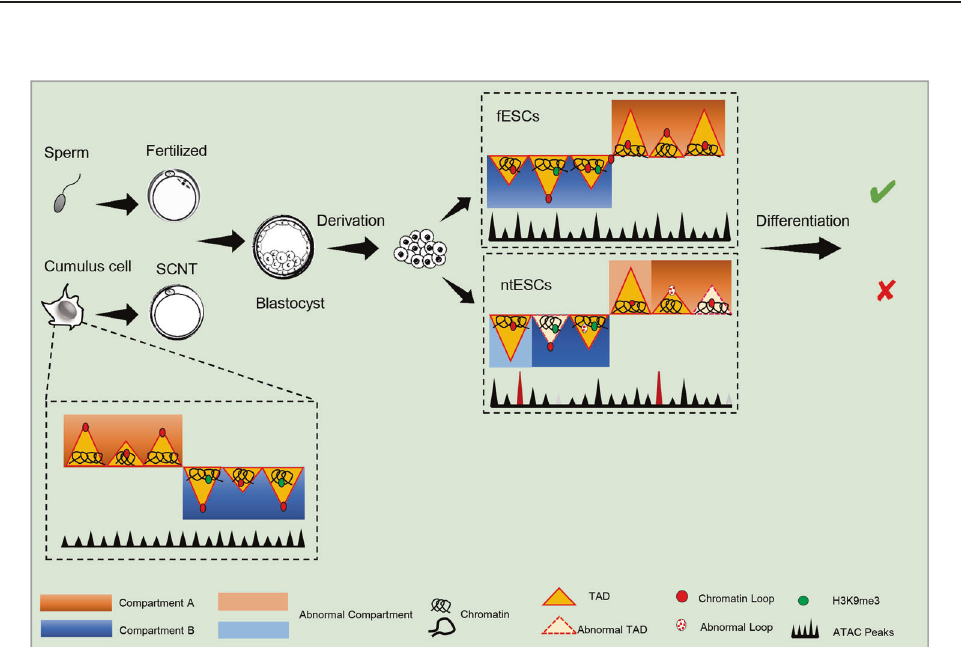
Fig. 7 Comparison of 3D chromatin structures between ntESCs and iPSCs. A , Barplots showing the percentages for those A-to-B and B-to-A compartment switches from CCs to ESC in NT process and from MEF to ESC in iPSC process (200 Kb resolution). The percentage numbers are shown in ntESCs and iPSC. ESC represents the same chromatin compartmentalization between fESCs and E14. B The Venn diagrams show the overlap of compartment switches between NT process and iPSC process. The percentages and classi fi cation labels are also shown. C The heatmap showing the PC1 values of the common compartment switches between two processes. The numbers of A-to-B and B-to-A reprogrammed compartments in the NT and iPSC processes are shown in the left side of heatmap respectively. D The heatmap shows the PC1 values of NT-speci fi c (left) and iPSC-speci fi c (right) compartment switches. The numbers of NT-speci fi c A-to-B (left, top), NT-speci fi c B-to-A (left, bottom), iPSC-speci fi c A-to-B (right, top) and iPSC-speci fi c B-to-A (right, bottom) reprogrammed compartments are shown on the left side of the heatmaps, respectively. ‘ Donor speci fi c ’ means that there are different compartmental states between CCs and MEF, but the NT process or iPSC process is reprogrammed. ‘ Method speci fi c ’ means that there are same compartmental states between CCs and MEF, but different compartmental states between ntESCs and iPSC. The differentially expressed genes between ntESCs and iPSC related to method-speci fi c compartment switches were displayed on the right side of each heatmap. E The GO analyses on the genes related to Method-speci fi c categories in the NT-speci fi c and iPSC-speci fi c compartment switches.